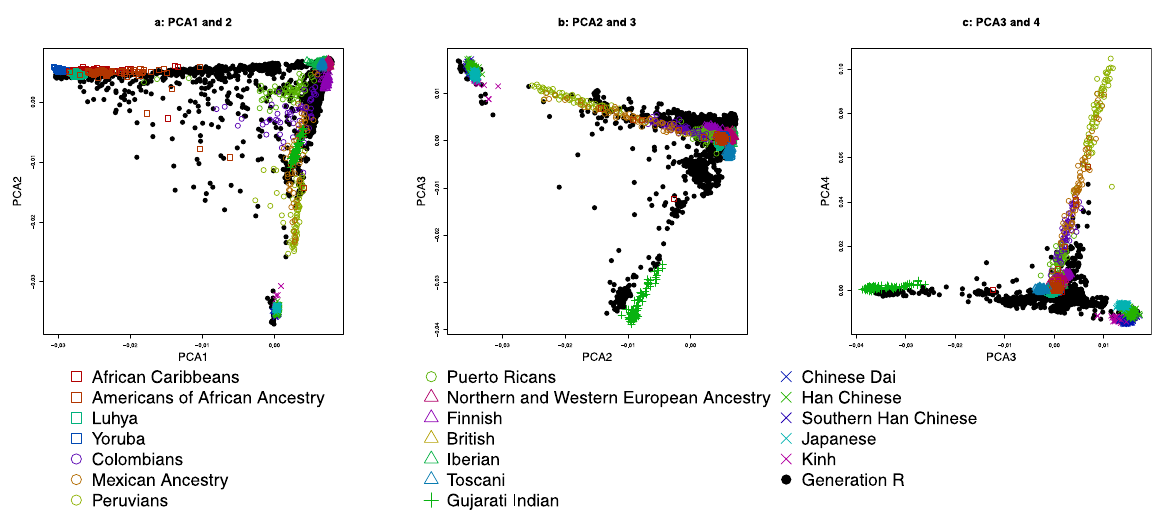
Figure 2. ( a – c ) Comparison of genetic ancestry in the Generation R Study sample and the 1000 Genomes phase 3 populations based on the first four principal components of ancestry (PCA). Squares mark African, circles Ad Mixed American, triangles European, crosses South Asian and X indicates East Asian